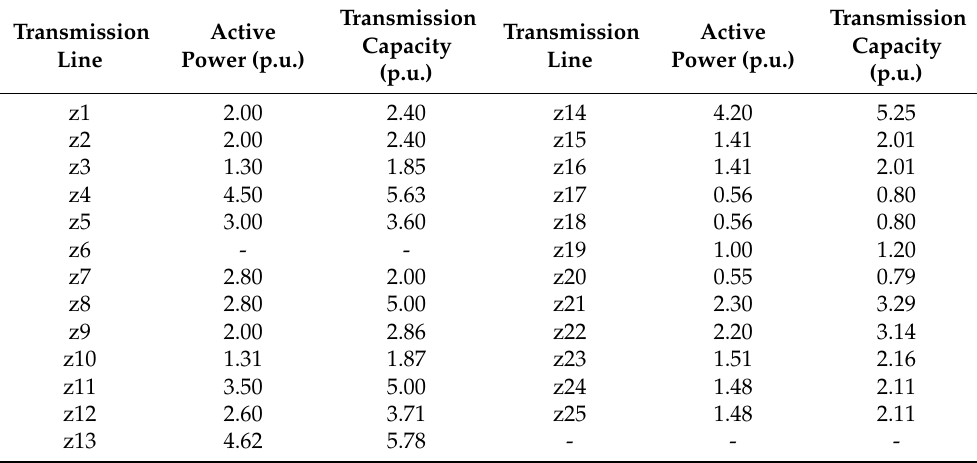
Table 7. Active power and maximum power capacity of transmission lines in the regional power system.